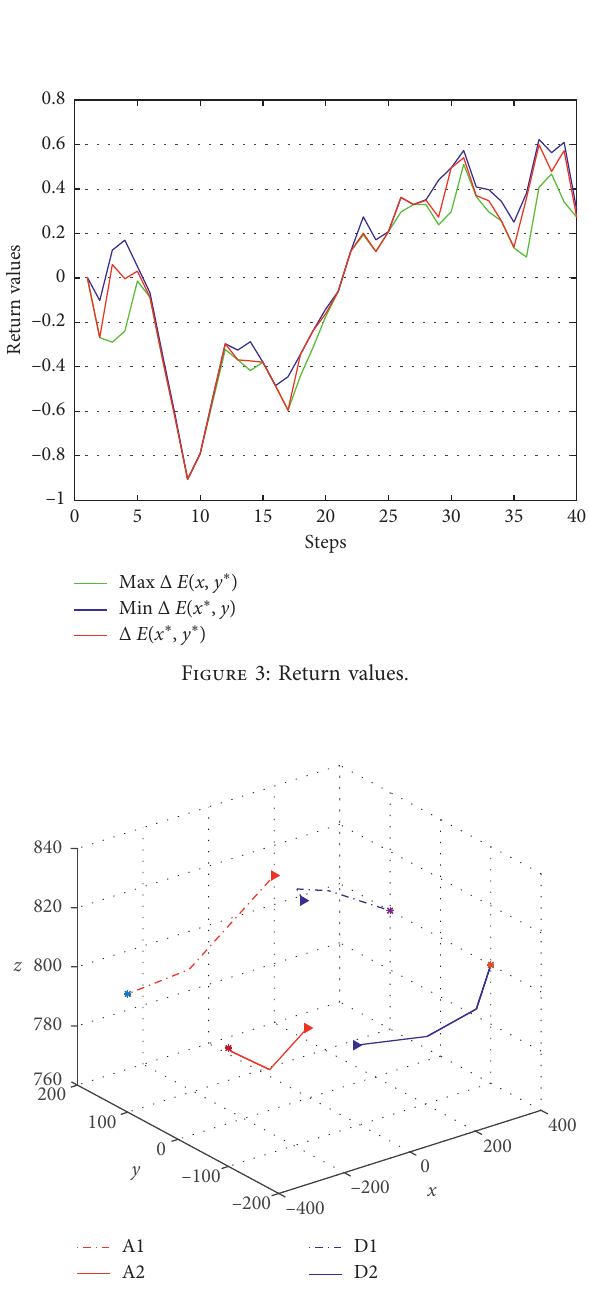
Figure 4: Multi-UUV cooperative dynamic maneuver decision-making: stage